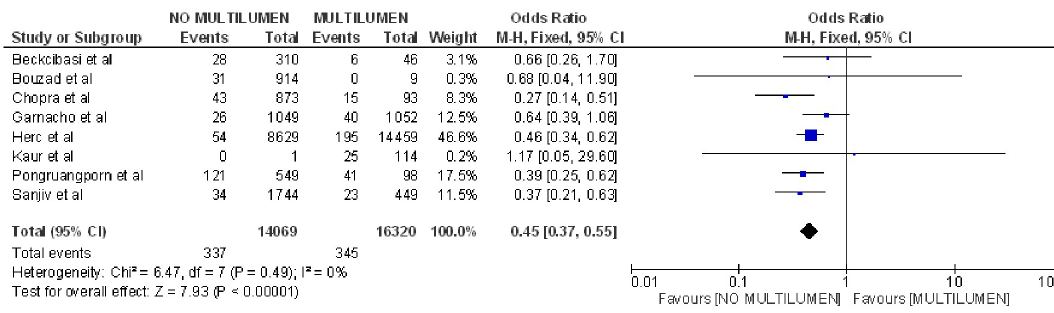
Fig 7. Forest plot of multilumen catheter and CLABSI.